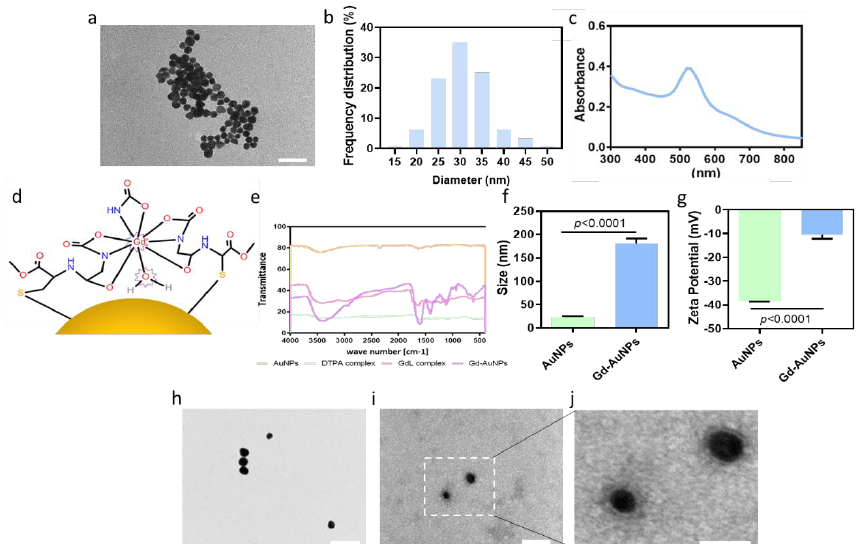
Figure 2. Gd-AuNP characterization. ( a ) TEM image of the pristine AuNPs; scale bar = 200 nm. ( b ) Size distribution of the AuNPs. ( c ) Absorbance spectrum of the AuNPs. ( d ) Scheme of the Gd-AuNPs. ( e ) FTIR analysis of the different steps in Gd-AuNP synthesis: pristine AuNPs in orange, DTPA complex in green, GdL complex in pink, and Gd-AuNPs in purple. ( f ) Diameter of the conjugated AuNPs as indicated by DLS. ( g ) Charge of the conjugated AuNPs as indicated by zeta potential measurements. ( h – j ) TEM images of ( h ) pristine AuNPs and ( i , j ) Gd-AuNPs after negative staining; scale bars = 100, 50, and 25 nm, respectively.